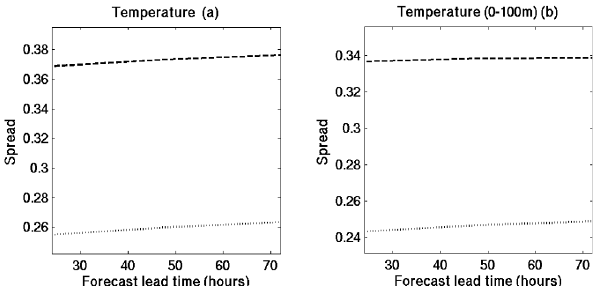
Fig. 3. Ensemble spreads of temperature for r (dotted) and q (dashed) as functions of forecast lead time. The spread values are averaged over the 109days from 1 June to 17 September 2012, and over the full observation space (a) , the layer between 0 and 100m (b)